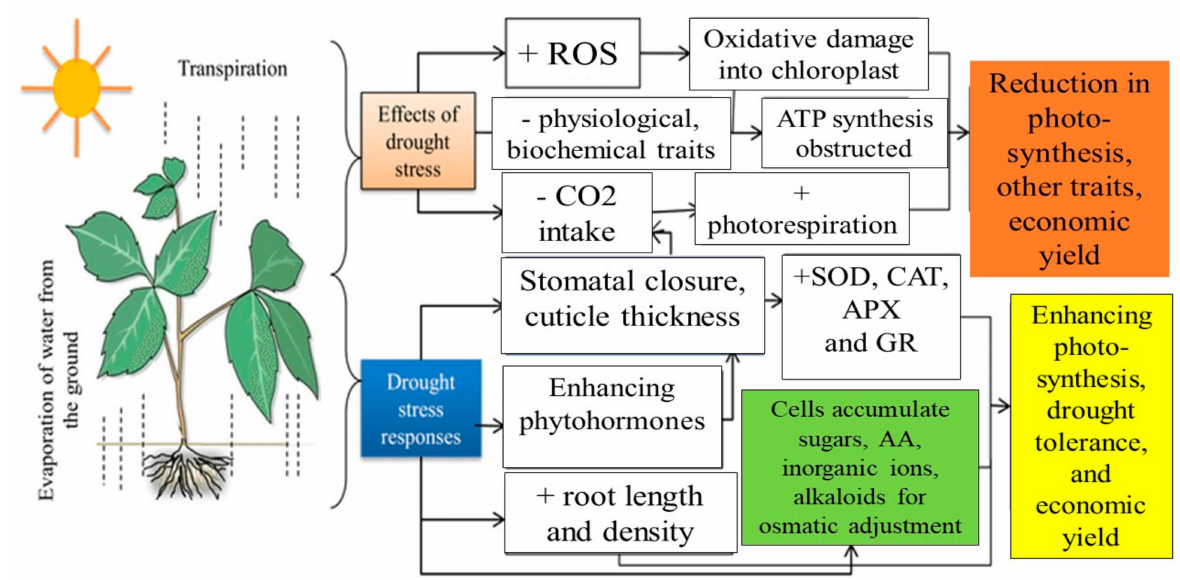
Figure 2. Adverse effects and adaptations of plants to drought stress, modified from Ullah et al. [63]—means reduce; + means